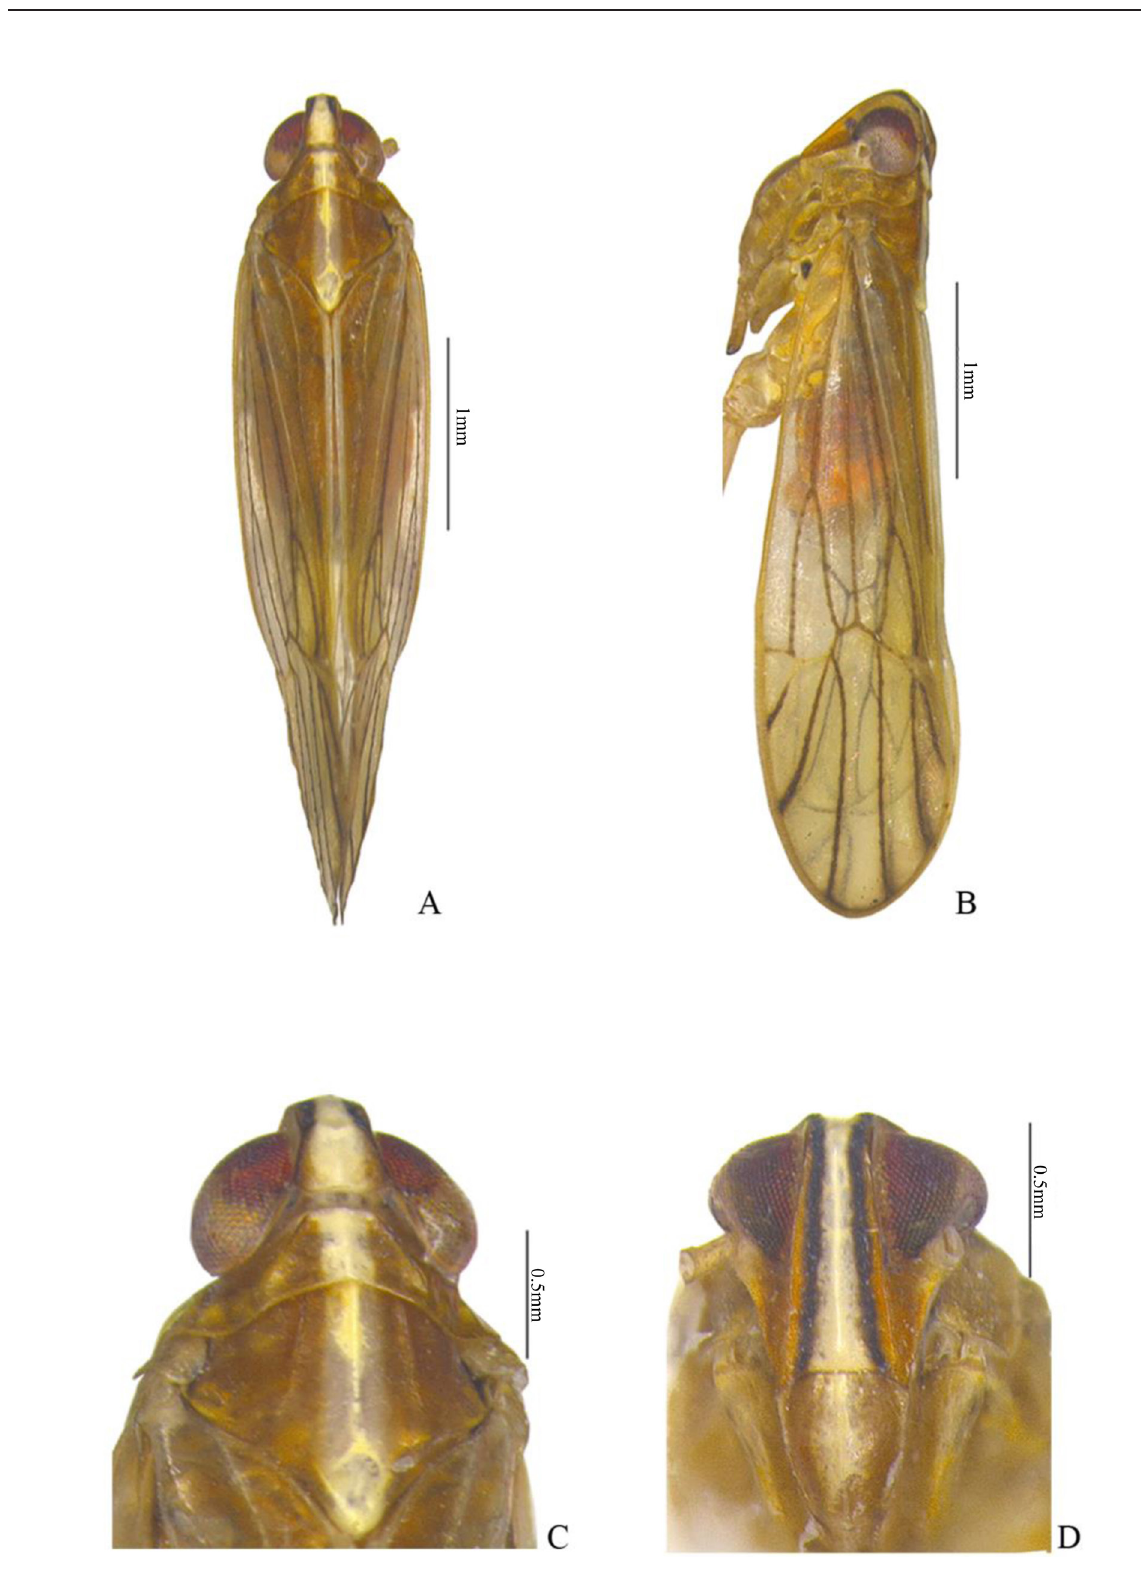
Fig. 1. Parasogata sexpartita sp. nov., holotype ♂ (NPC HEMT7). A . Habitus, dorsal view. B . Habitus, lateral view. C . Head, pro- and mesonotum, dorsal view. D . Head, ventral